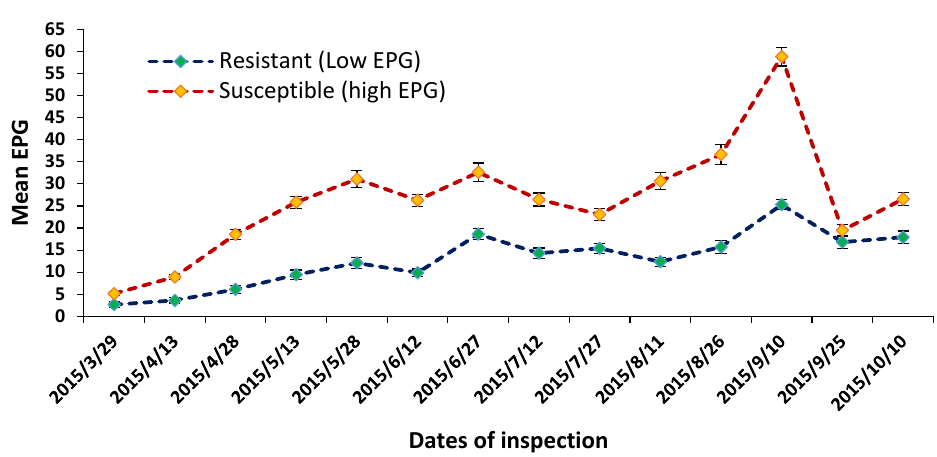
Figure 1. Fortnightly mean egg per gram (EPG) in feces are shown in resistant (low EPG, n = 48) and susceptible (high EPG, n = 74) groups of Yichang White Goats (YWGs). The X -axis represents dates of inspection, the Y -axis represents mean EPG, and error bars represent standard error of mean (SEM). Table 1. Weight gain, egg per gram (EPG), and blood parameters comparison of low EPG offspring group and high EPG offspring group of Yichang White Goats (YWGs) ( n =